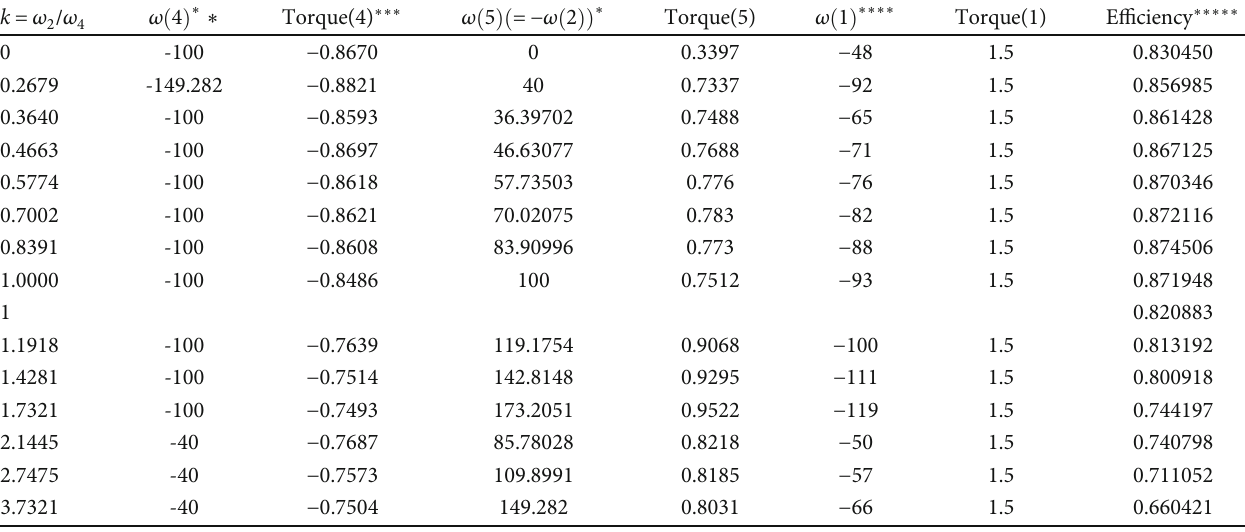
Table 3: Experimental data for the two input PGT shown in Figure 3 when the torque on link 1 is 1.5 [49] ∗ . / ω k = ω 2 4